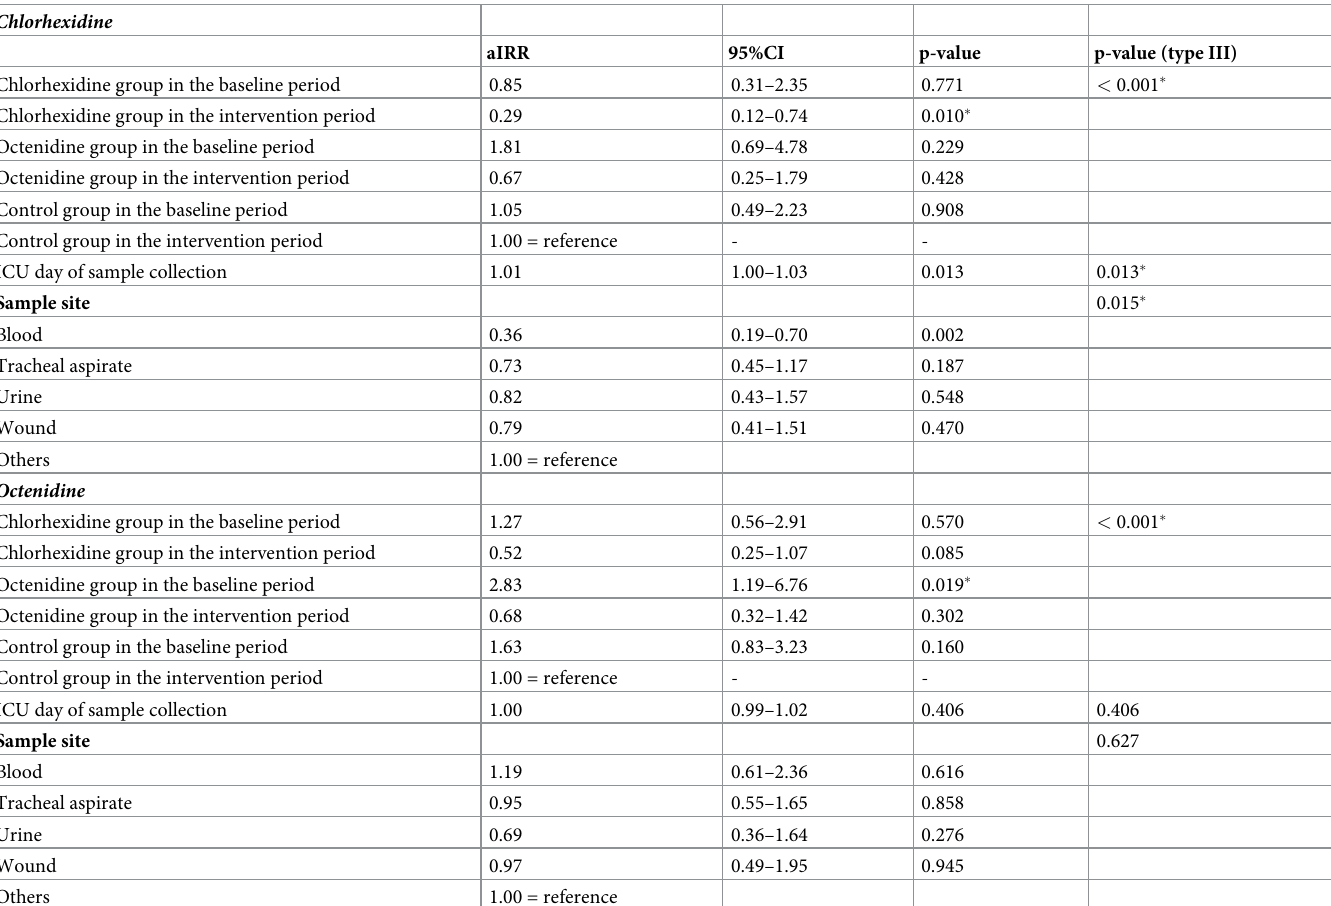
Table 3. Generalized estimating equation models for the outcomes chlorhexidine and octenidine susceptibility of bacterial isolates (reported by MIC � species-spe- cific chlorhexidine and octenidine MIC 50 (yes /